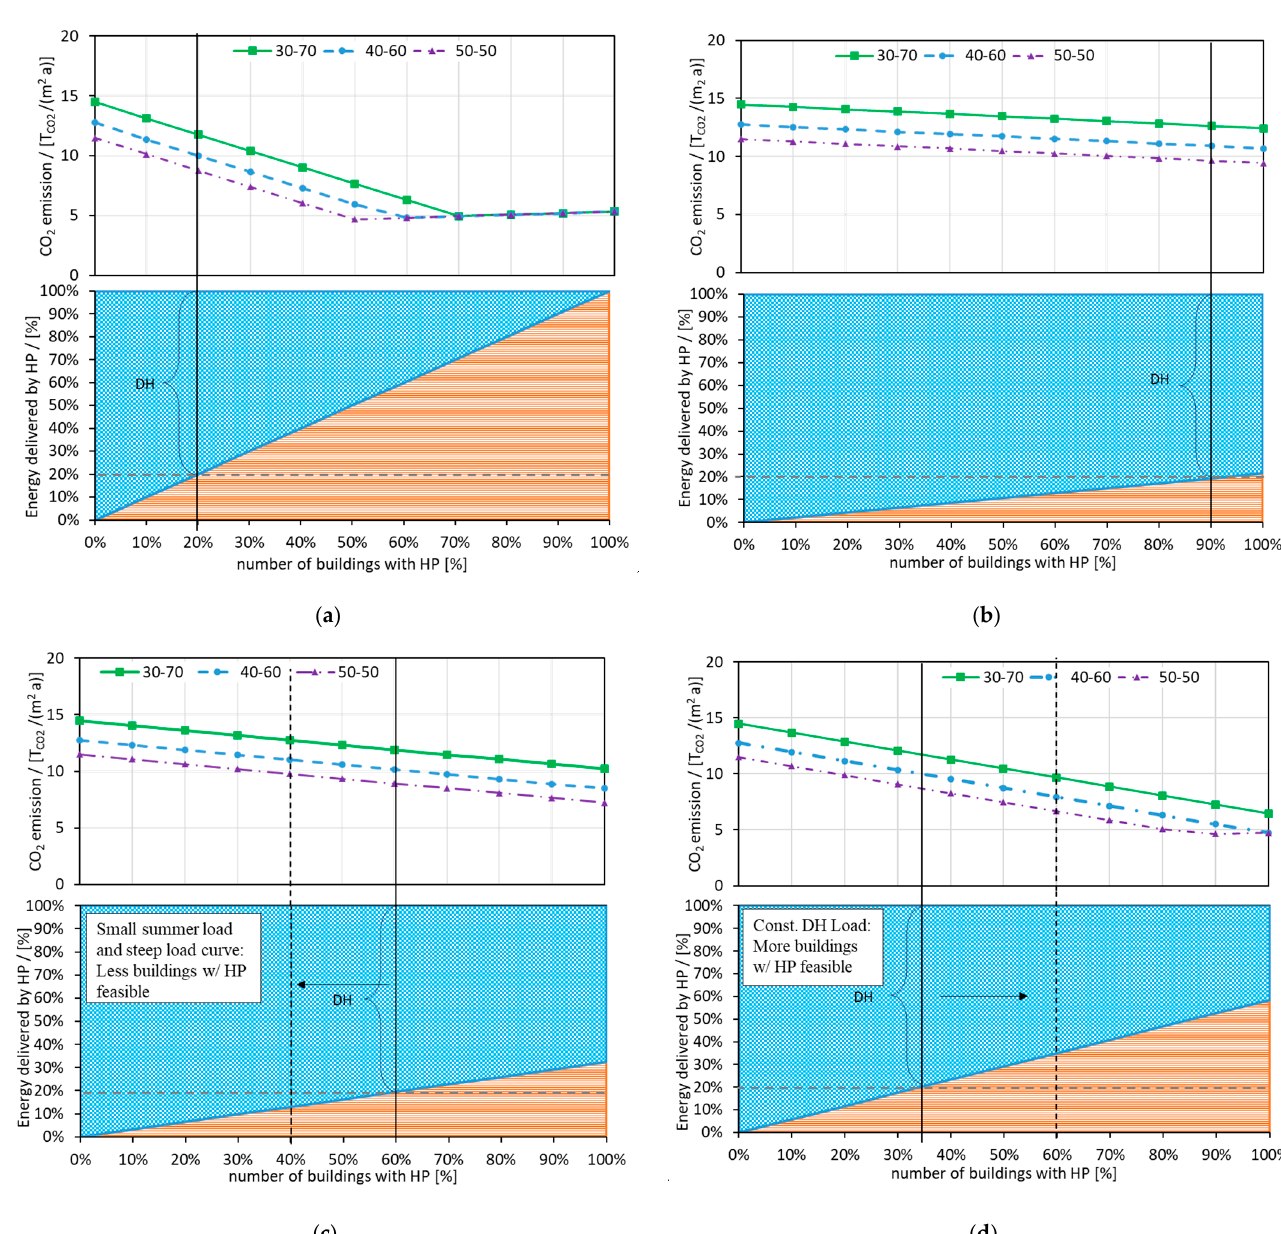
Figure 18. Specific CO 2 emissions and energy share of HP and DH considering the integration of ( a ) HP for SH and DHW, ( b ) decentral DHW Booster HP, ( c ) building–wise HP for DHW, and ( d ) build- ing–wise HP for SH. The CO 2 emissions are reported for different DH scenarios considering differ-